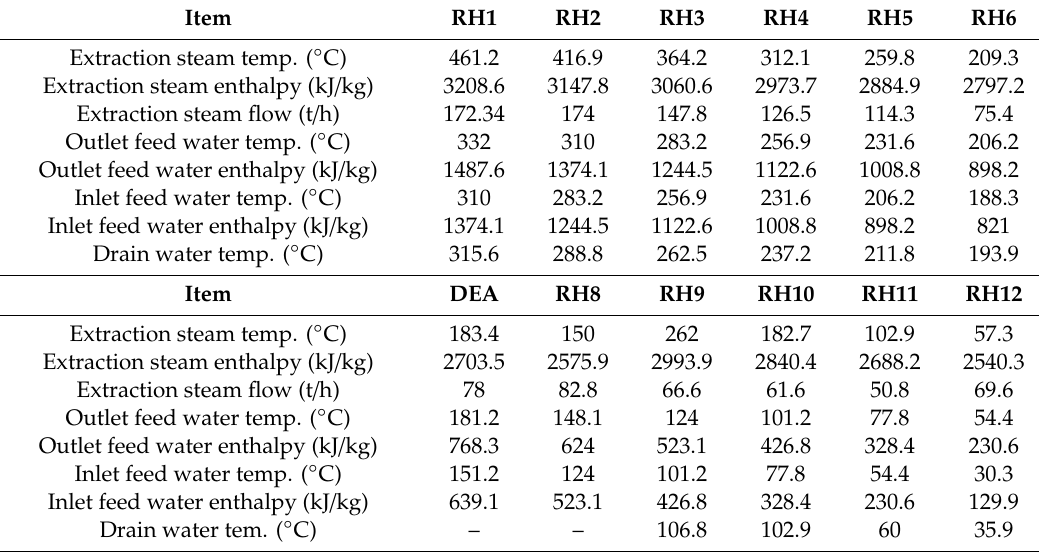
Figure 7. Extraction steam flow loss. Table 5. Main parameters of regenerative heaters.